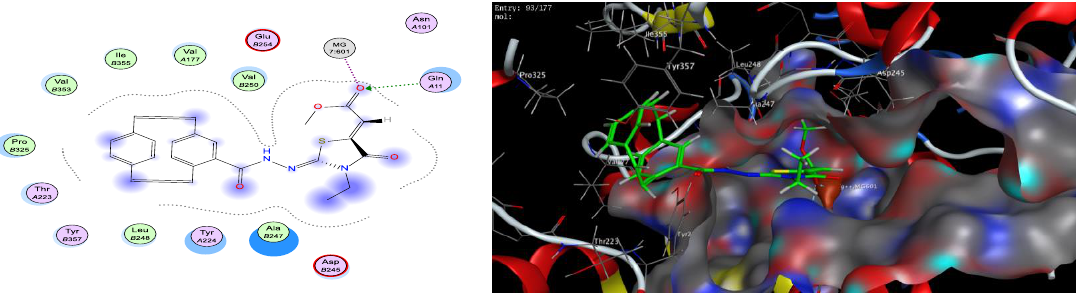
Figure 19. The 2D and 3D diagrams illustrate the binding mode of 3d interacting with the colchicine binding site of β -tubulin.